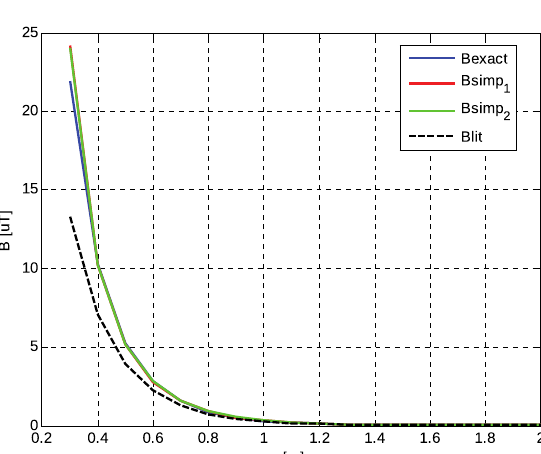
Figure 4. Parameter a 3 versus radius α and pitch p of the helix.